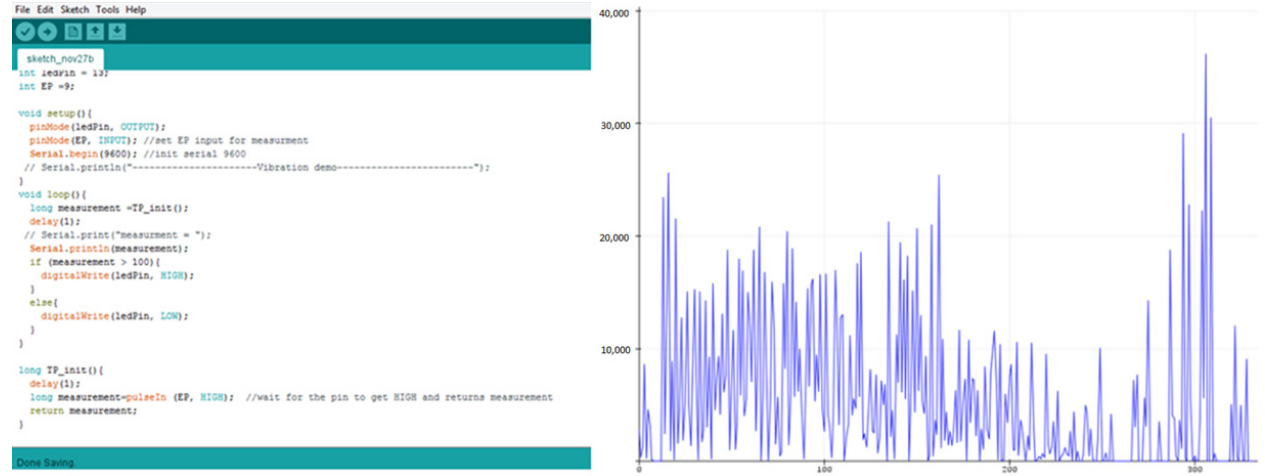
Figure 1. Machining of SS304 work piece with coated tool insert.